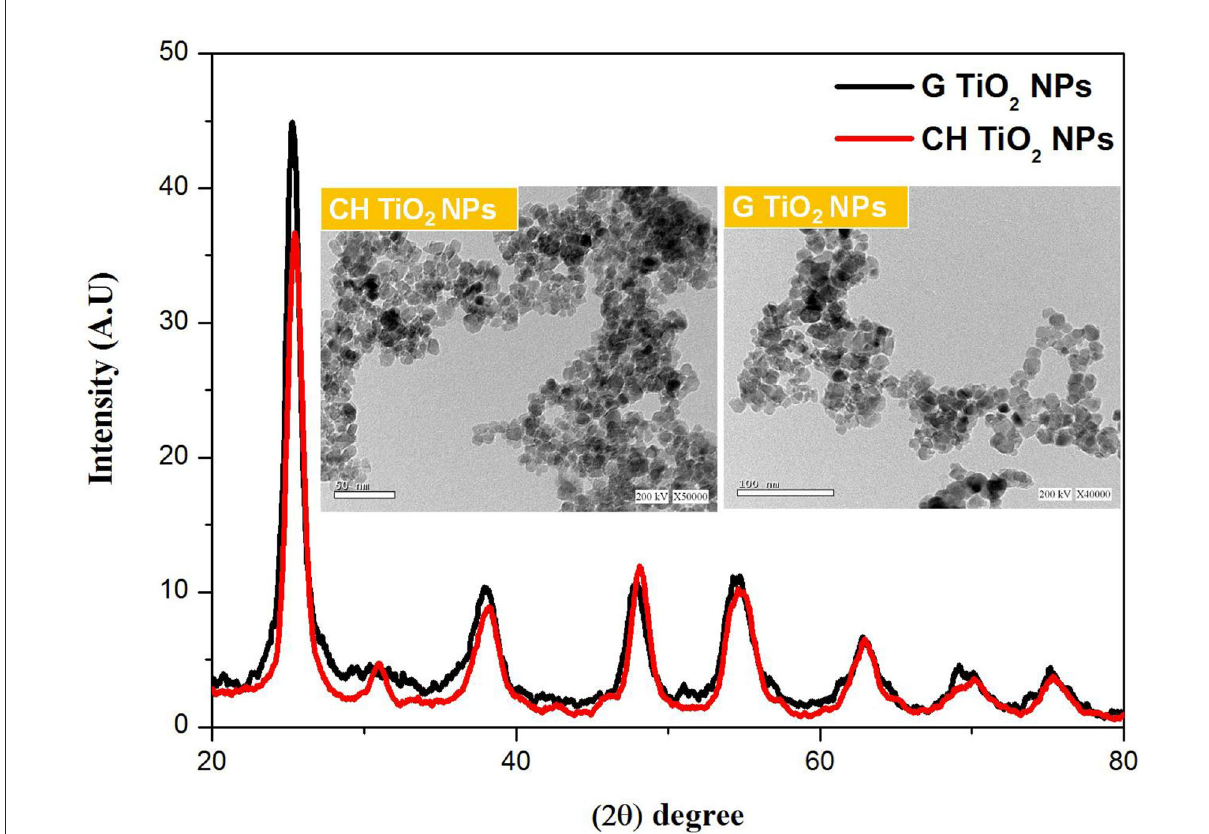
FIGURE1 XRD pattern combined with HRTEM images of CHTiO 2 NPs and GTiO 2